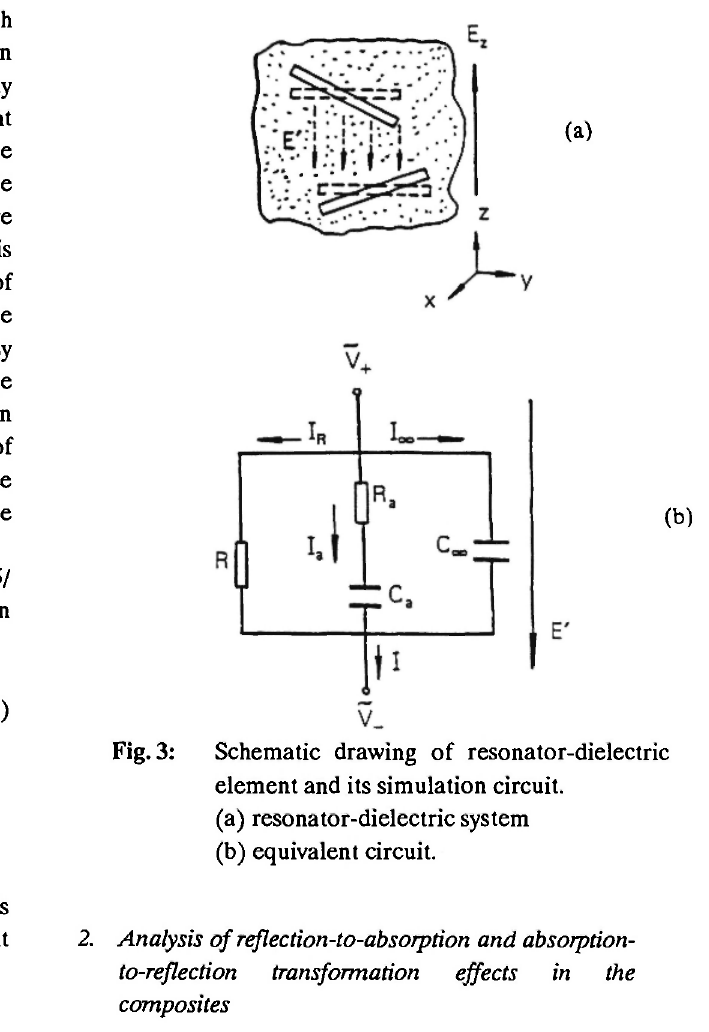
Schematic drawing of resonator-dielectric element and its simulation